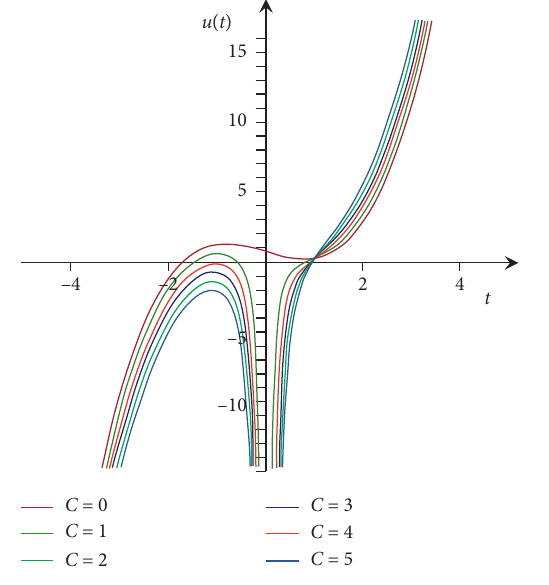
Figure 1: Integral curve graphics for solutions of (4) and (5) problems.